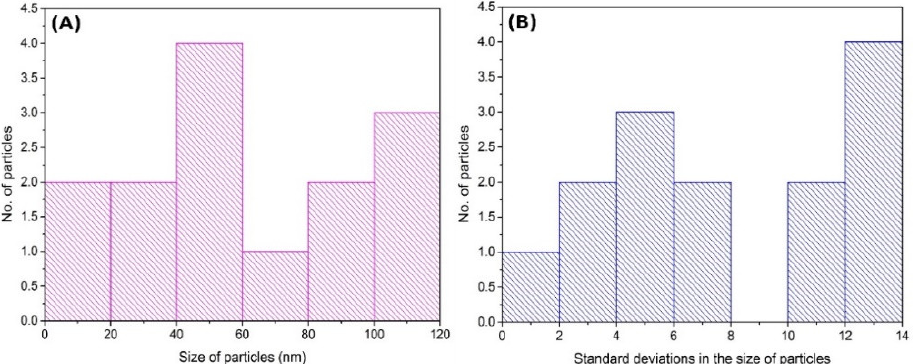
Figure 6. TEM images of CPN, subfigure ( A ) represents particles size at 500 nm scale and subfigure ( B ) represents particles size at 100 nm scale.